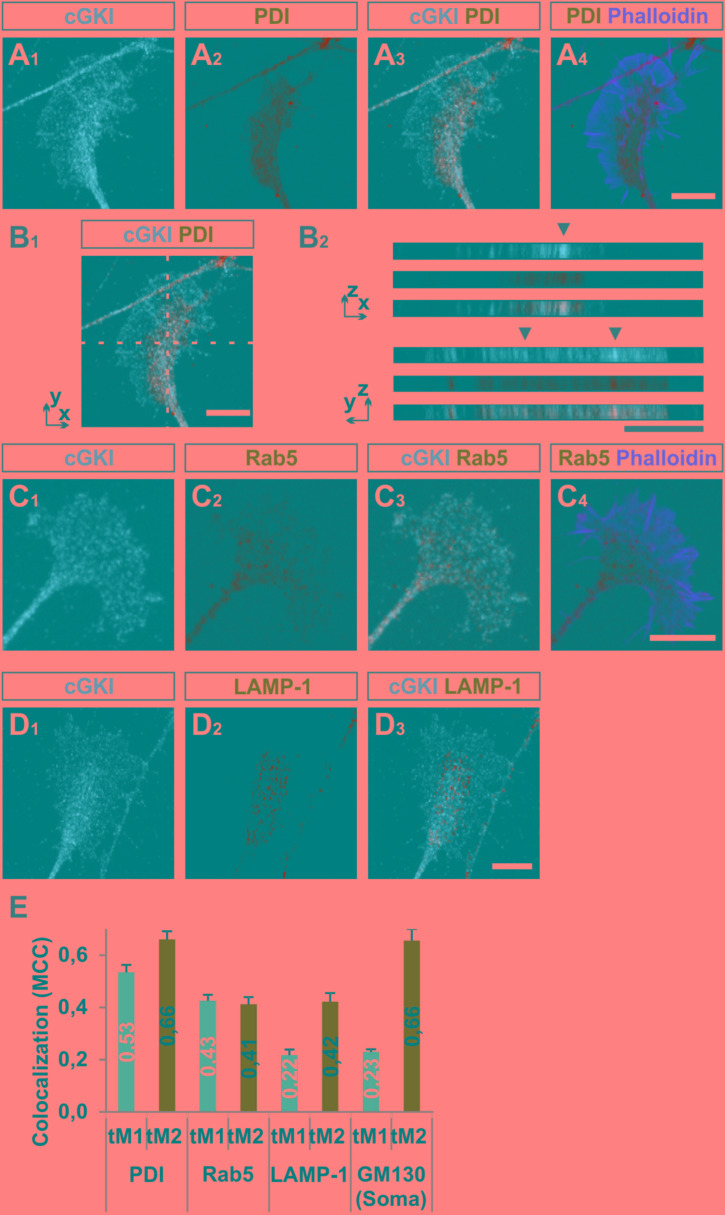
Colocalization of cGKI with marker proteins of intracellular compartments in DRG growth cones. (A1–A4) Colocalization of cGKI and the ER marker PDI in growth cones of E12.5 mouse DRG explants. A z-stack image was taken. For comparison the pattern of F-actin together with the localization of PDI is shown in (A4). (Note: in the upper left corner an axon shaft is growing above the growth cone). (B1,B2)
z-stacks taken at the dashed lines showing colocalizing cGKI and PDI (arrowheads). In (B2)
z-stacks are presented as single colors or merged (lower panel). (C) Co-localization between cGKI and Rab5. F-actin is indicated by phalloidin staining. (D) Co-localization between cGKI and LAMP-1. (E) Quantification of co-localizations using Mander’s colocalization coefficient (MCC). MCC values are given within the columns. tM1 represents the proportion of cGKI-positive structures colocalizing with structures positive for a specific marker. tM2 represents the proportion of structures positive for a specific marker colocalizing with cGKI-positive structures. For each condition at least 10 growth cones or cell somata were analyzed PDI: 26, Rab5: 17, LAMP-1: 12 growth cones and for GM130: 10 somata. Error bars represent SEM. Scale bars, 10 μm.